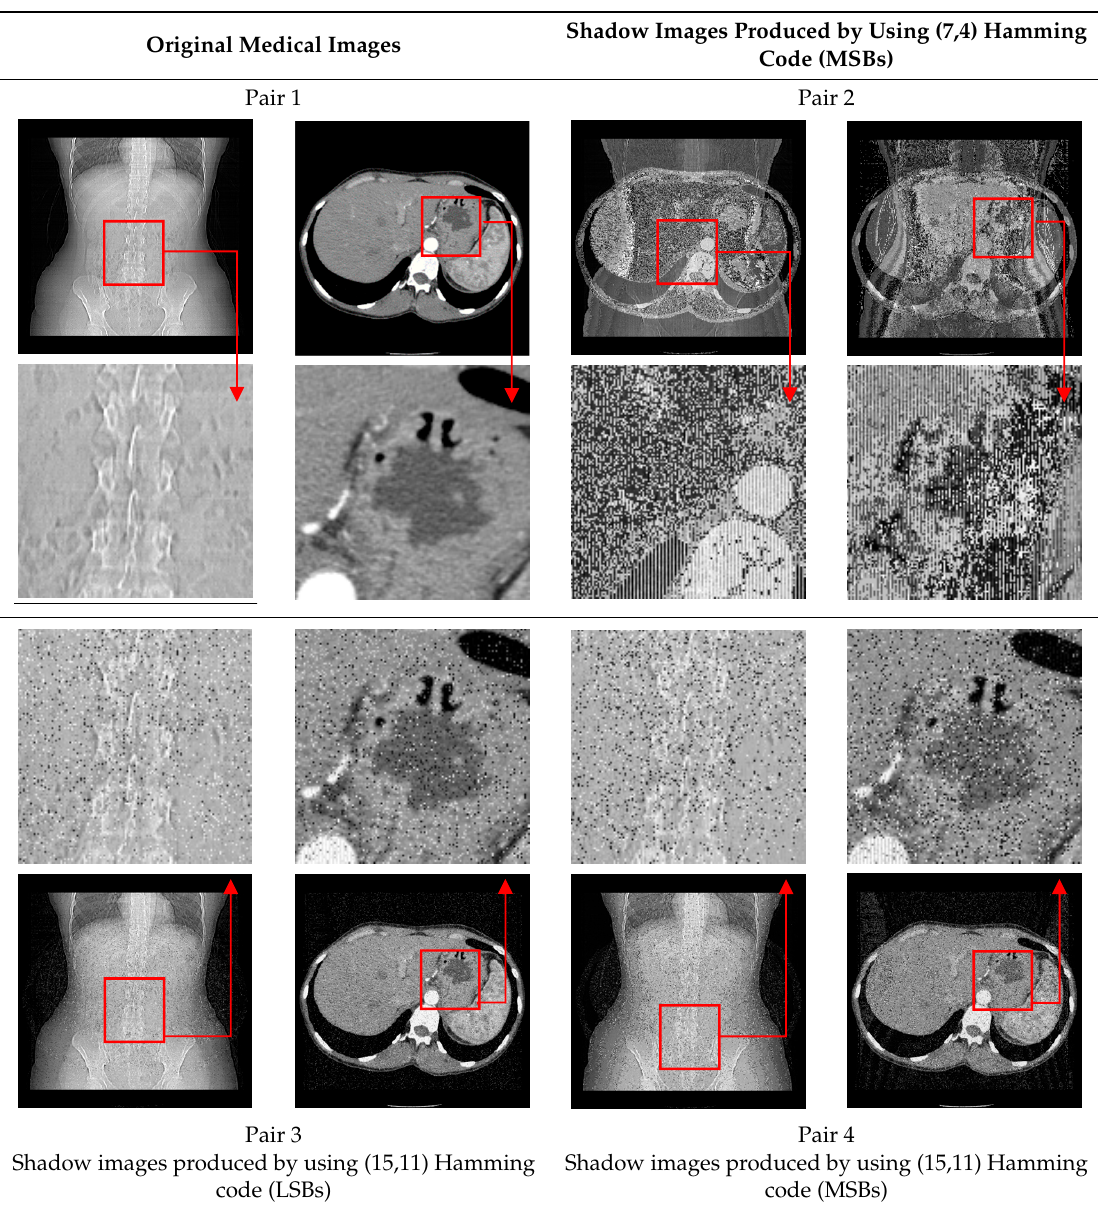
Table 3. Comparisons of specific features between original images and shadow images using the proposed scheme.